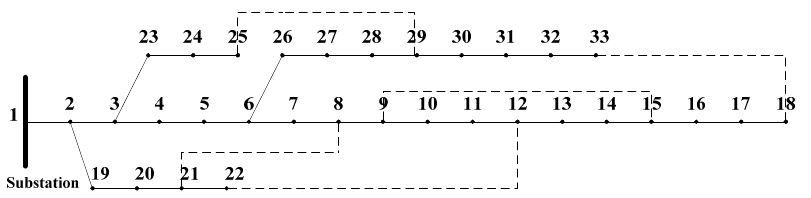
Figure 3. Schematic diagram of IEEE 33-bus system.